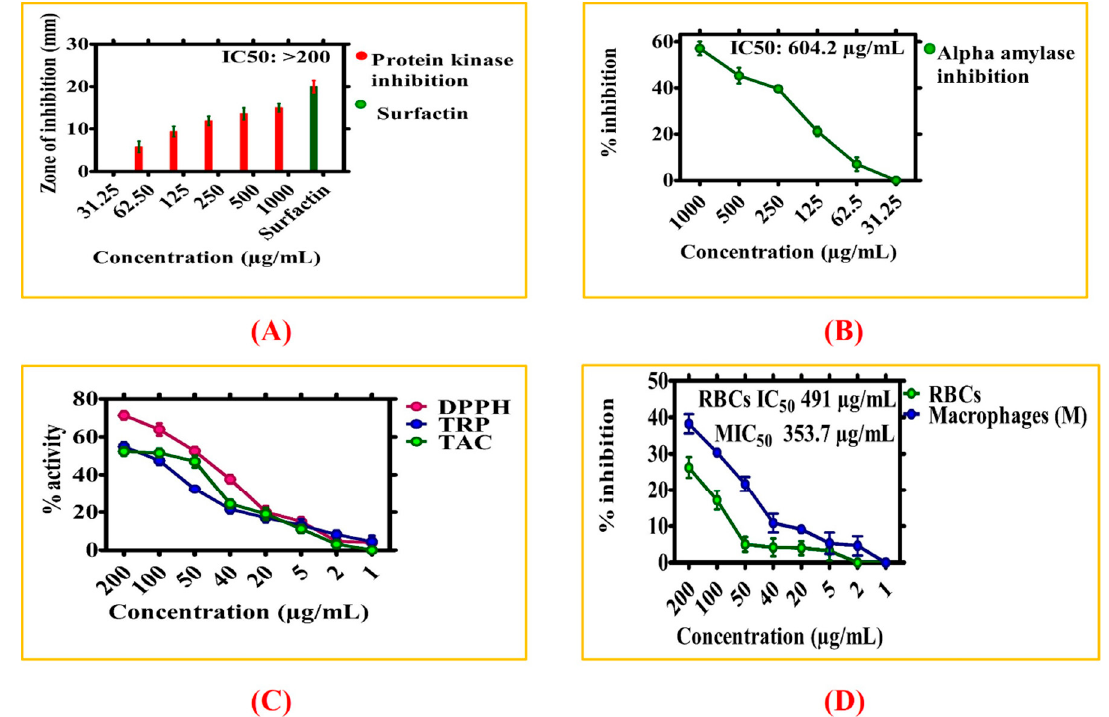
Figure 8. ( A ) Inhibition potential of Geranium wallichianum mediated ZnONPs against protein kinase ( B ) Inhibition potential against alpha amylase ( C ) Antioxidant potential of ZnONPs ( D ) Biocompatibility potential of ZnONPs against human RBCs and macrophages.